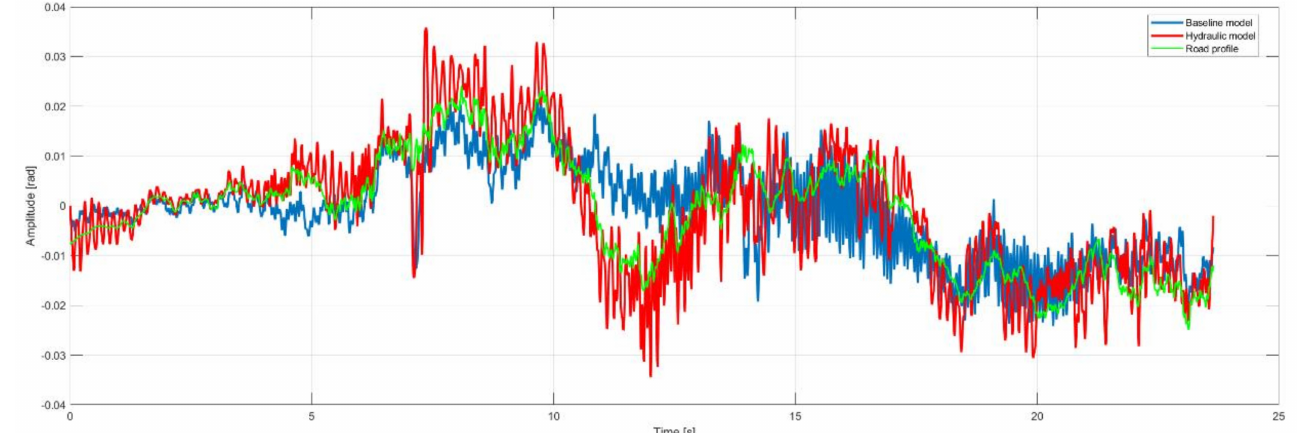
Figure 24. Front left wheel absolute vertical motion over a realistic road profile and external accelerations.